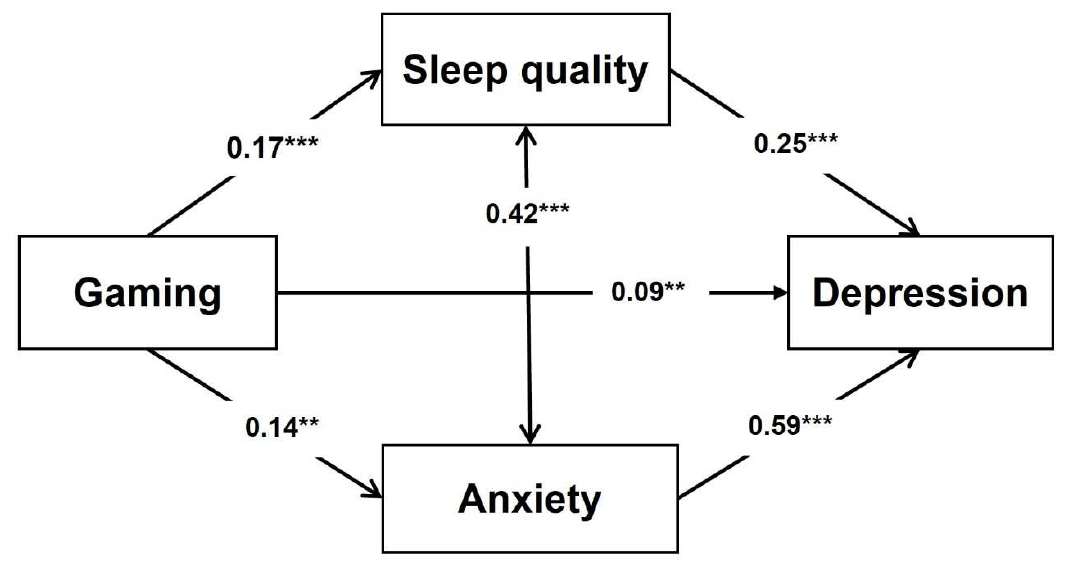
Figure 2. Mediating Model 1 for depression (parallel mediation). Note: The numbers on the paths are standardized β coefficients. ** p < 0.01, *** p < 0.001.